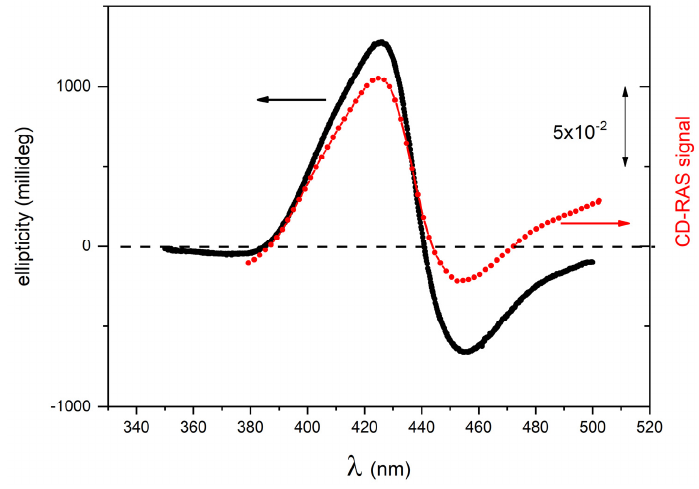
Figure 4. CD-RAS experimental spectrum for sample A1 (red curve, right vertical axis), compared with the ellipticity spectrum measured for the same sample by a commercial spectrometer for circular dichroism (black curve, left vertical axis). The CD-RAS spectrum is reported as measured, without correction. The double-arrow reported in the figure is the unit for the CD-RAS data. Here,